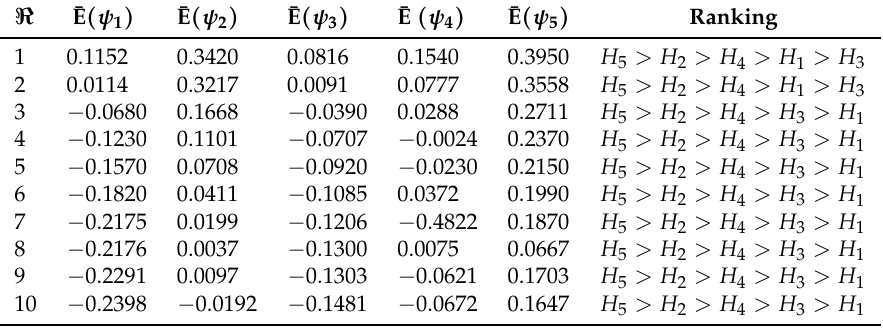
Table 3. Ranking order of influence of the parameters (cid:60) using the PFDWG operator.